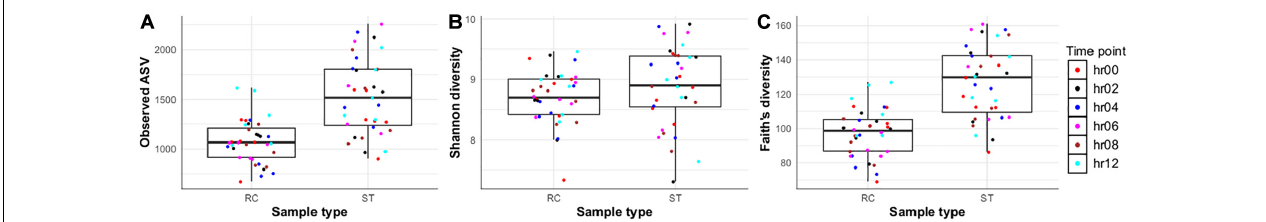
FIGURE 3 | (A–C) Comparison of alpha diversity of liquid fraction from samples collected using ruminal cannula (RC) and stomach tube (ST) at different sampling times relative to feeding [before feeding (hr00); 2 h after feeding (hr02), 4 h after feeding (hr04); 6 h after feeding (hr06); 8 h after feeding (hr08); and 12 h after feeding